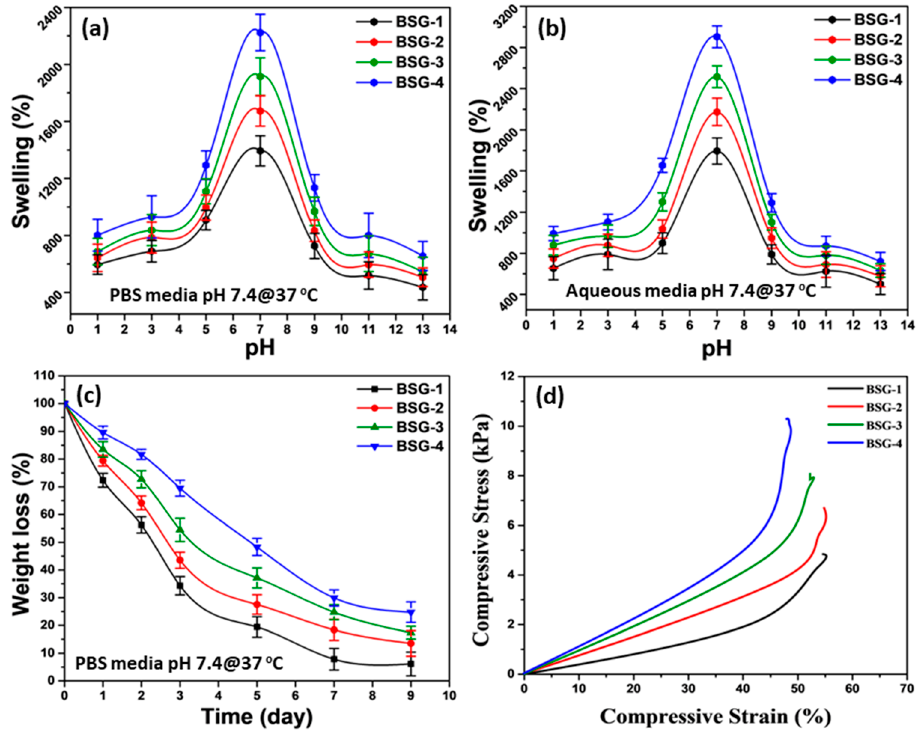
Figure 4. The physicochemical analysis of the hydrogels was conducted to study to analyze the behavior of the hydrogel with biofluid during application. Swelling in PBS ( a ) and aqueous ( b ) media, ( c ) biodegradation in PBS buffer solution ( d ), and stress–strain curve of hydrogels.